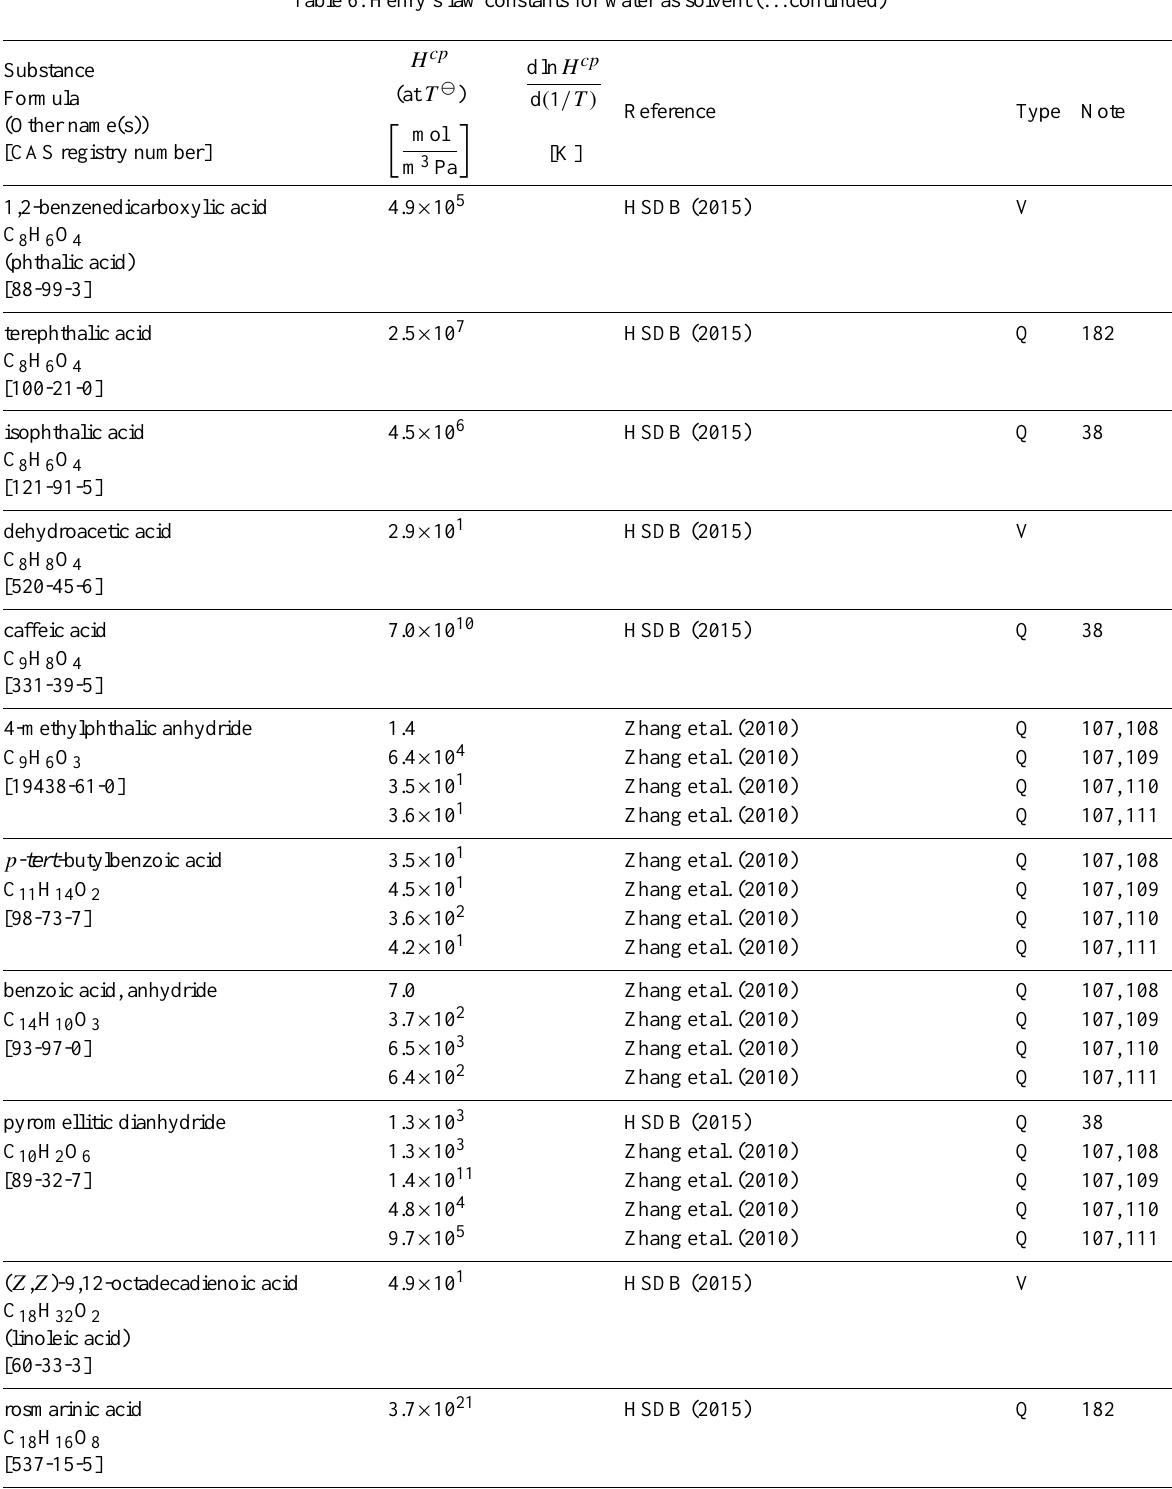
Table 6: Henry’s law constants for water as solvent